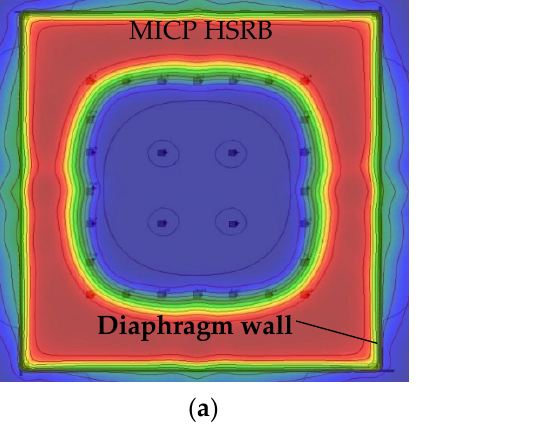
Figure 22. Diagram of bacterial migration driven by the seepage field in the inner circle after the infusion of the bacteria solution was stopped: ( a ) Horizontal; ( b ) Vertical.